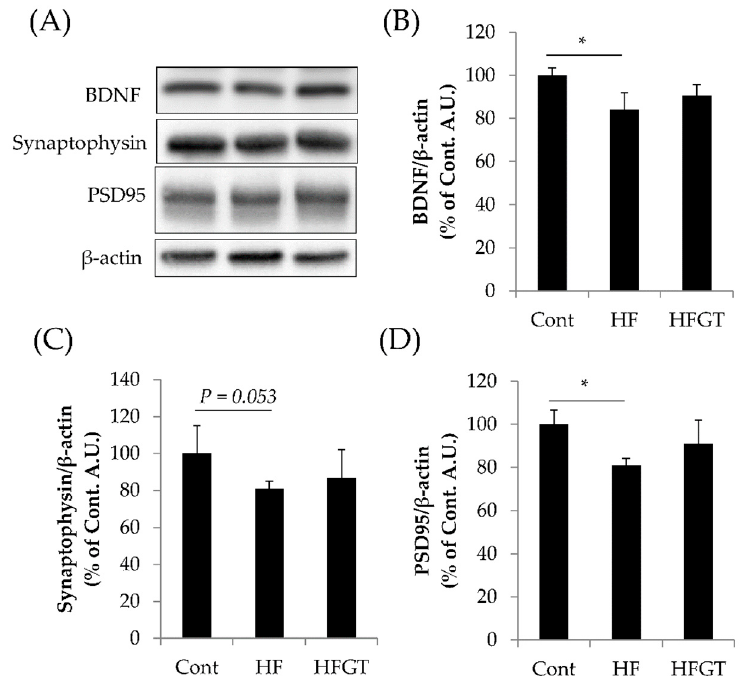
Figure 4. E ff ects of GTEs intake on the levels of BDNF, synaptophysin, and PSD95 in SAMP8 mice. ( A ) Representative Western blot images (all images are provided in Figure S2); and quantification of protein levels for: ( B ) brain-derived neurotrophic factor (BDNF); ( C ) synaptophysin; and ( D ) postsynaptic density protein 95 (PSD95). Data are means ± S.D. One-way ANOVA followed by Dunnett’s test was used for comparison among groups ( N = 4). * p <